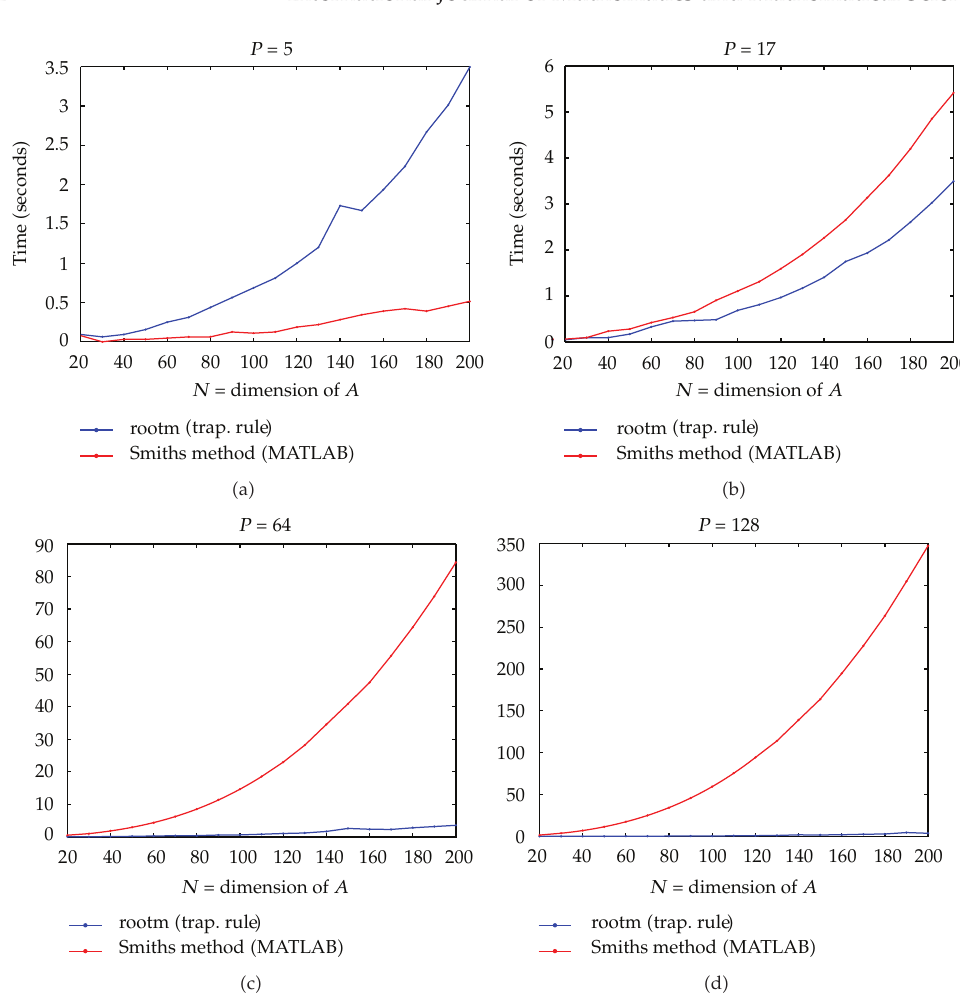
Figure 7: Time in seconds for computing A 1 /p for Lehmer matrix.